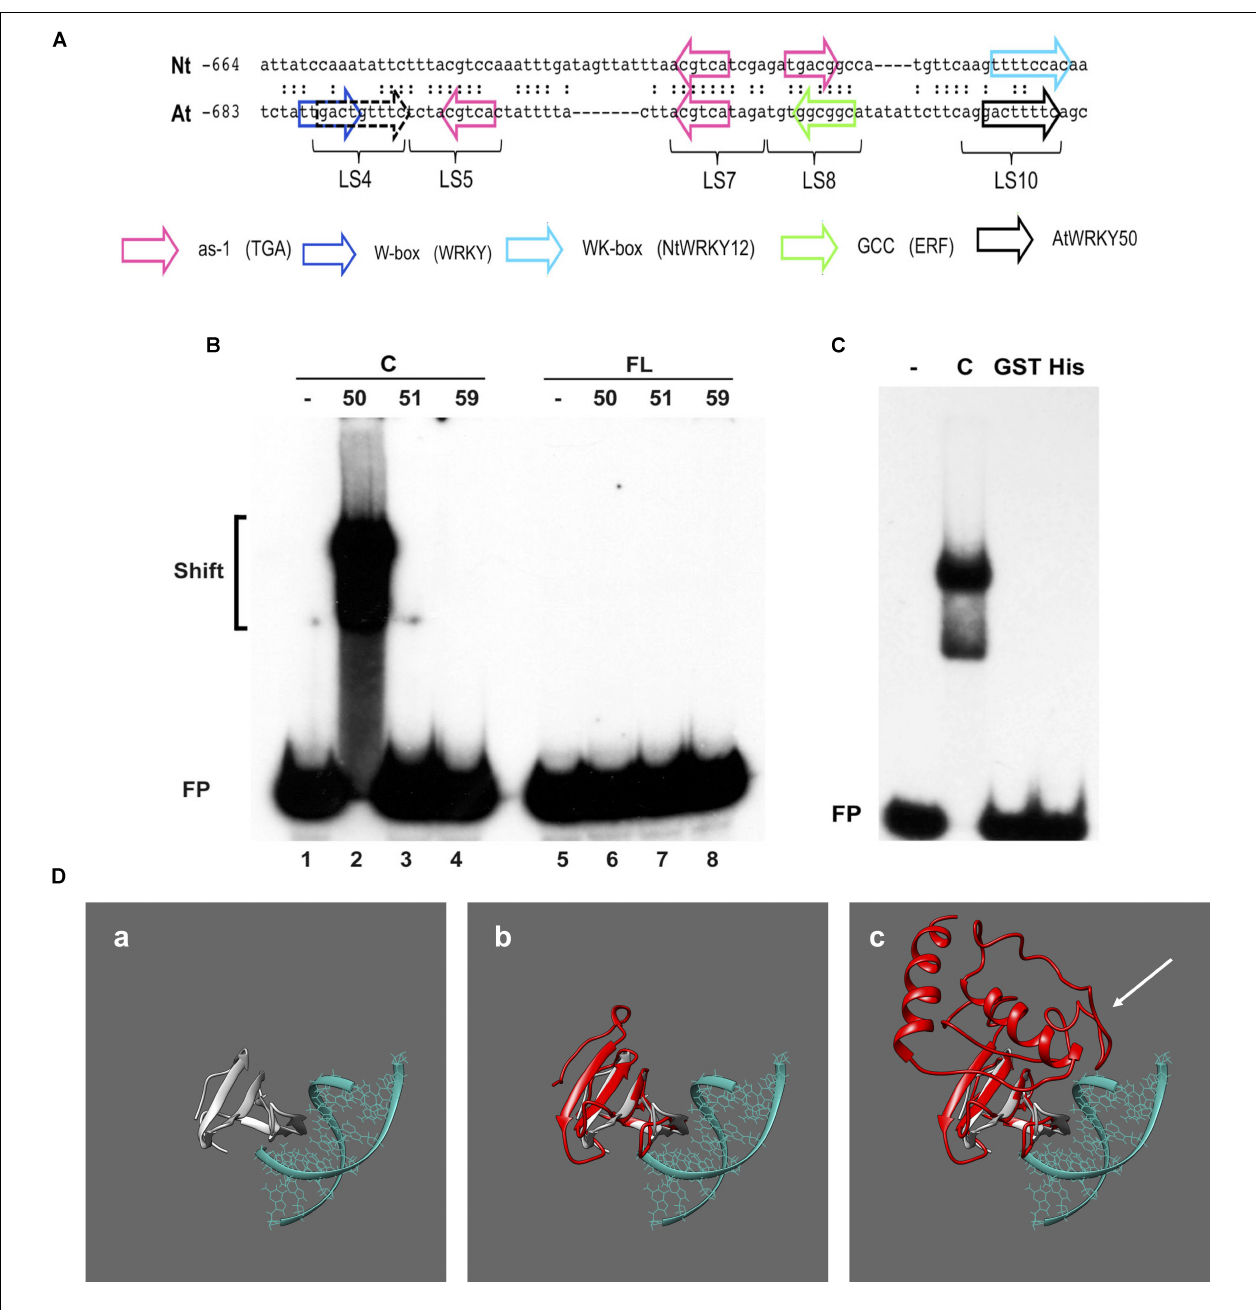
FIGURE 3 | AtWRKY50 binds to the PR1 promoter. (A) Comparison of sequences in the promoters of tobacco PR1a (Nt) and Arabidopsis PR1 (At). Only the sequence of the top strands is given. The sequences of the promoter regions are shown with gaps to allow maximal alignment. The position of the leftmost nucleotide relative to the transcription start site is indicated. Corresponding nucleotides are indicated by colons. Colored block arrows mark consensus binding sites for various transcription factors, as indicated. The direction of the arrow indicates whether the consensus sequence is in the top (right-pointing arrow) or bottom strand. The dashed and solid black arrows mark the binding sites for AtWRKY50. The positions of sequence elements used in the linker scanning analysis of the PR1 promoter by Lebel et al. (1998) are indicated (LS). (B) EMSAs were performed with an 80-bp fragment of the PR1 promoter and GST-tagged C-terminal halves (Lanes C) or full-length (Lanes FL) versions of AtWRKY50, -51 and -59, as indicated above the lanes. (C) EMSAs were performed with the same probe together with the GST-tagged C-terminal half (Lane C) and GST-tagged (Lane GST) and His-tagged (Lane His) full-length versions of AtWRKY50. In (B,C) , lanes labeled with the minus sign were loaded with the probe only. The positions of shifts and the unbound probe (FP) are indicated. (D) Modeling prediction analysis of C-terminal and full-length AtWRKY50 protein binding to DNA in silico . (a) shows the structure of C-terminal WRKY4-C domain bound to DNA from Yamasaki et al. (2012) onto which AtWRKY50 and its truncated form are superimposed. The overlap of the β -sheets and overall structure correlating with interactions is shown in (b) . The full length AtWRKY50 sequence also demonstrates a superimposable C-terminal region (c) but the additional protein structure was predicted to possess a large disordered region (shown with white